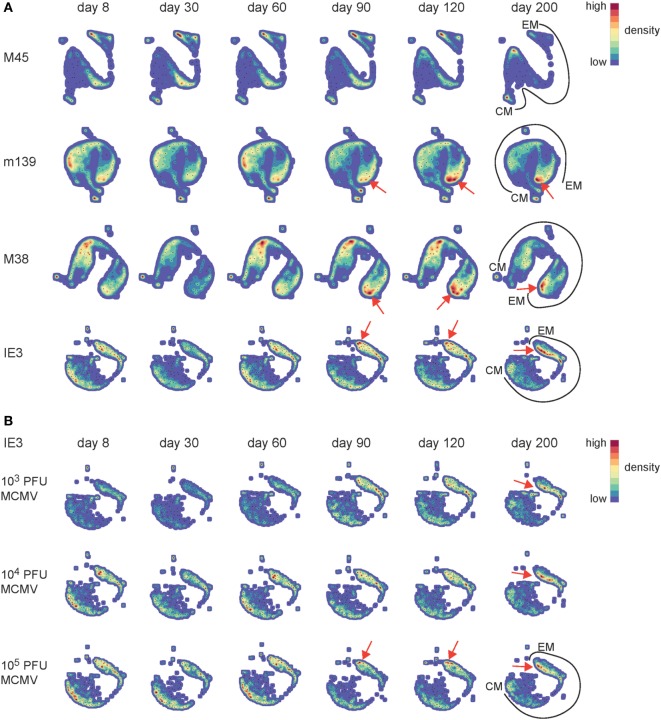
Progressive effector-memory (EM) CD8+ T cell differentiation is accelerated by high-dose CMV infection. Wild-type (WT) mice were infected with 103, 104, or 105 PFU mouse CMV (MCMV)-Smith. MCMV-specific CD8+ T cells in blood were stained with MHC class I tetramers combined with cell surface markers (CD62L, KLRG1, CD27, and CD44) at the indicated time points post-infection. (A) Cytosplore analysis of the MCMV-specific CD8+ T cells in time. A-tSNE plots depict the pooled phenotypical data of MCMV-specific CD8+ T cells of the 103, 104, and 105 PFU MCMV-infected mice for each time point after infection. (B) A-tSNE plots depict the phenotype of the IE3-specific CD8+ T cell response of the 103, 104, and 105 PFU MCMV-infected mice for each time point after infection (n = 16 mice per MCMV dose). Data were pooled from two independent experiments. In the A-tSNE plots, the differentiation path from the CM and EM phenotype is specified. The red arrows indicate the ongoing shift toward a higher advanced EM phenotype.